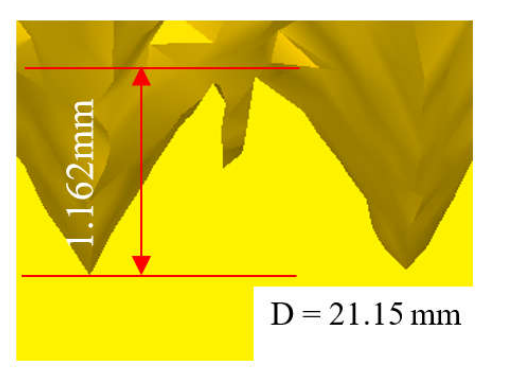
Figure 16. Thread morphology in numerical